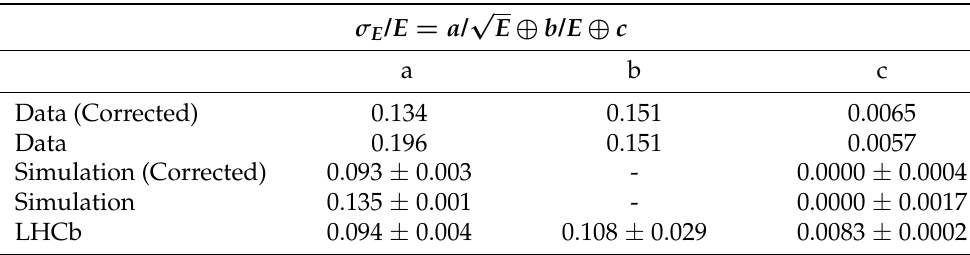
Figure 12. Energy resolution of the pre-shower corrected test beam data (black), the pre-shower corrected test beam simulation (red), and a parameterisation of LHCb test beam results using the same ECAL modules (green). The red line is a fit of the simulation points, with the addition of a 0.01 constant term. Table 3. Calorimeter energy resolution values seen in Figure 12, including the fit used by LHCb, the corrected and uncorrected test beam data, and the corrected and uncorrected test beam simulation. Note that the test beam simulation does not include a noise